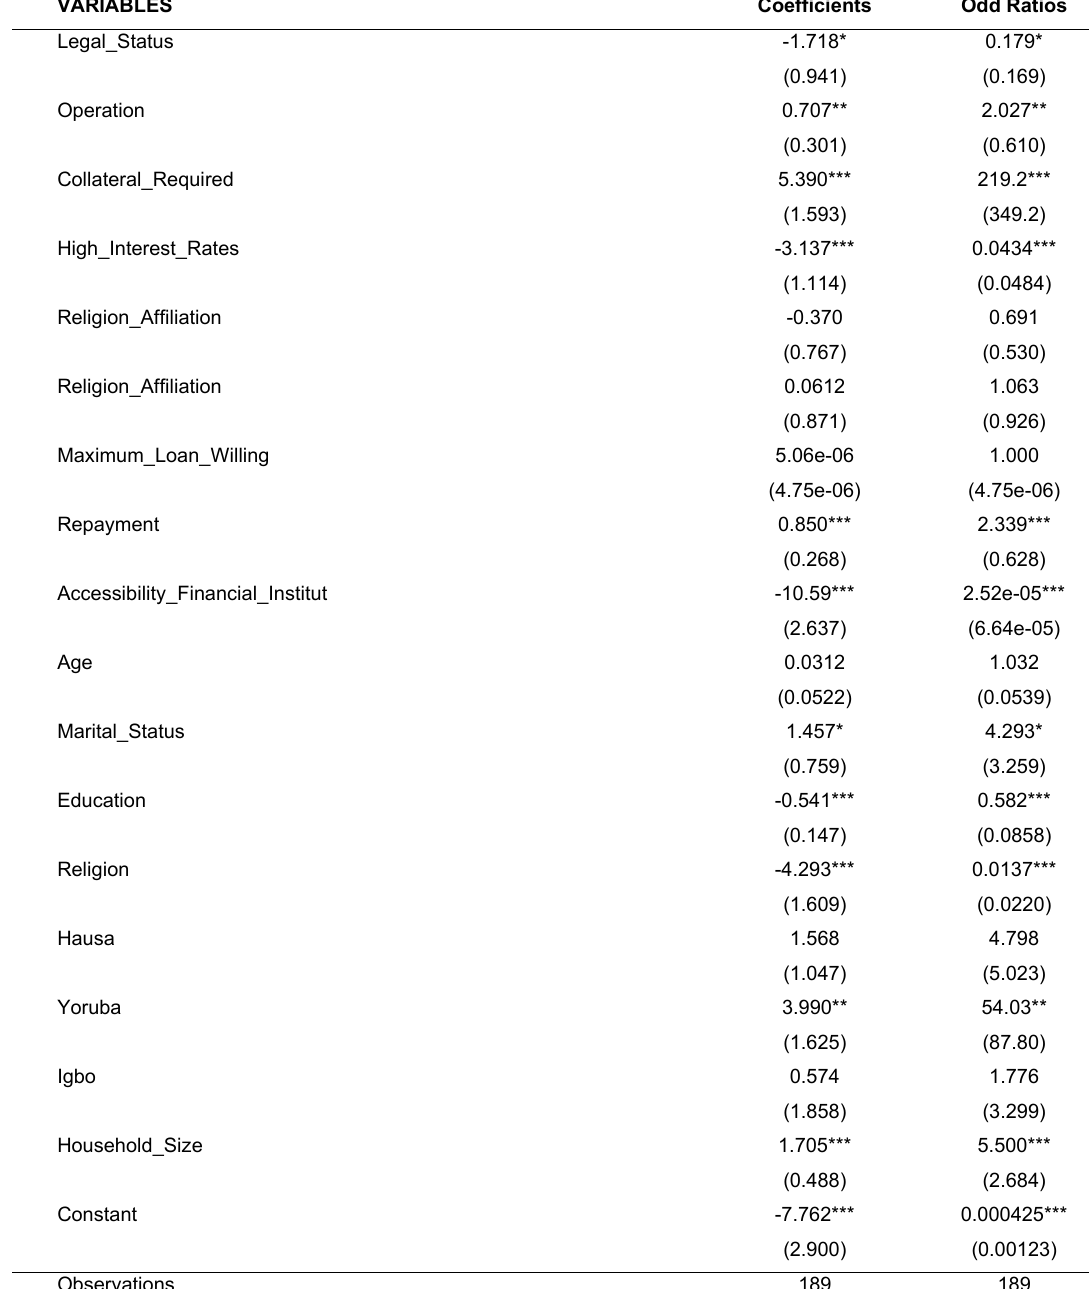
Table 3. Willingness to accept loan from financial institutions by women entrepreneurs